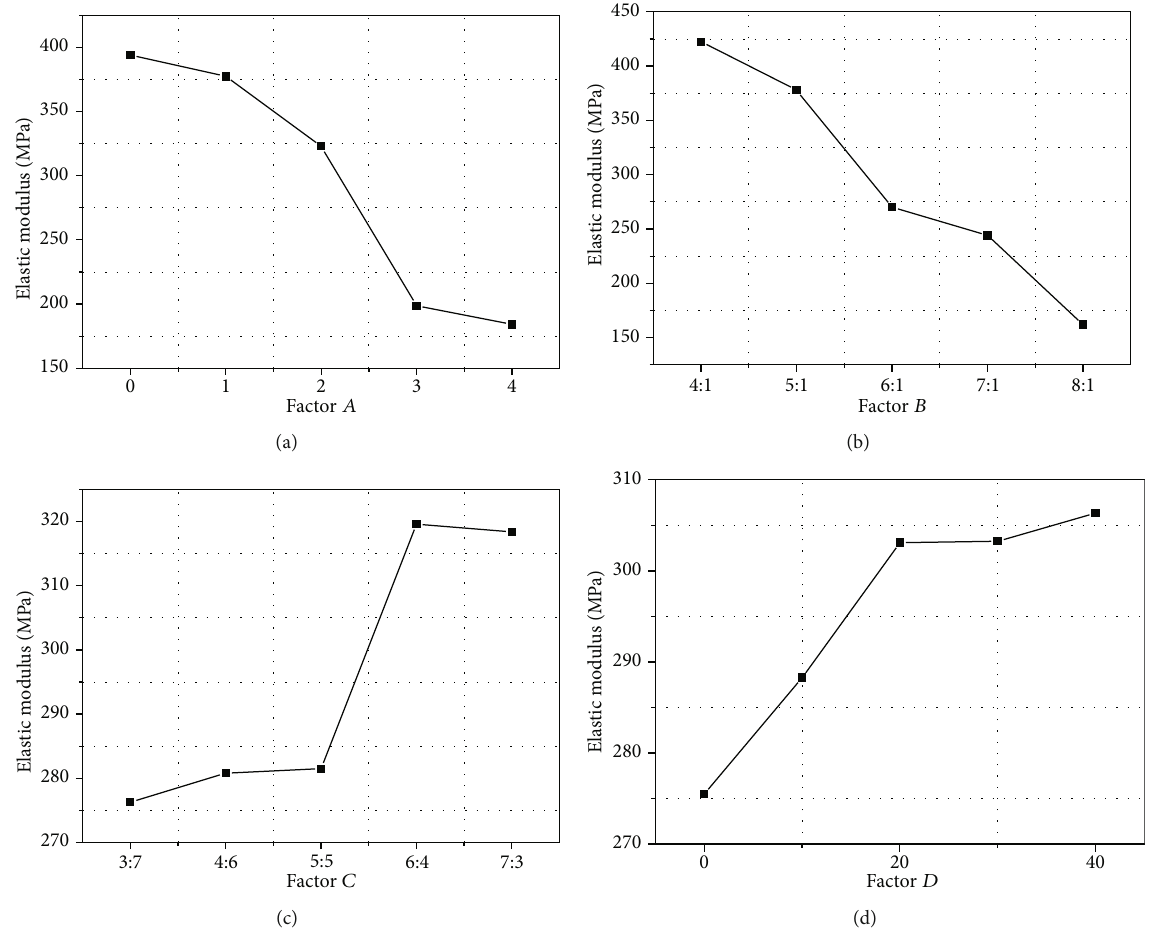
Figure 6: Intuitive analysis chart of the elastic modulus in fl uencing factors: (a) factor A , (b) factor B, (c) factor C , and (d) factor D .